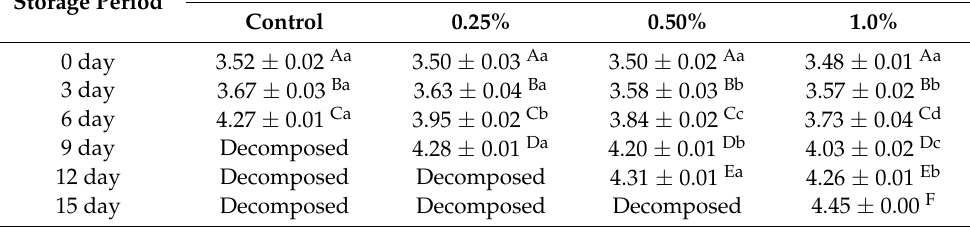
Table 9. Pattern of the staphylococcal count (log10 cfu/g) in minced beef treated with ethanolic Cassia glauca leaf extracts (0.25%, 0.5%, 1%) during the cold storage period at 3 ± 1 ◦ C (mean ± standard deviation